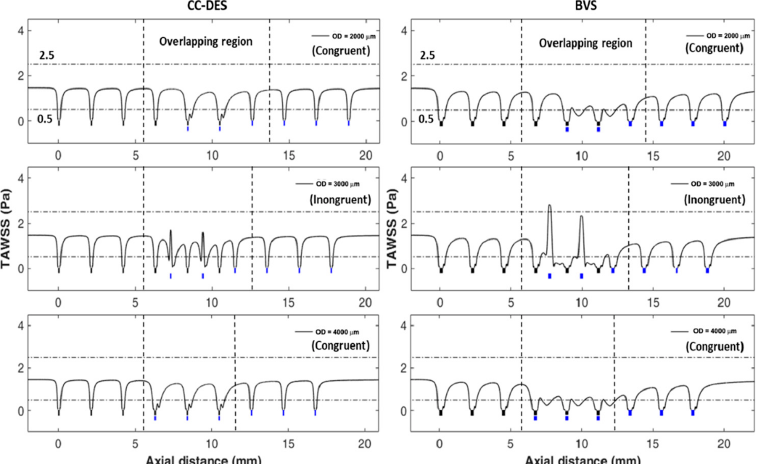
Figure 10. TAWSS distribution for overlapping configuration. For simplicity reasons, three representative configurations are displayed for each strut size. Strut locations on the X-axis are indicated with black and blue rectangles for the first and second strut respectively. Notice that axial distance = 0 mm corresponds to the location of the first stent. Three ranges can be defined: TAWSS < 0.5 Pa (Low TAWSS), 0.5 < TAWSS < 2.5 Pa (Normal TAWSS) and TAWSS > 2.5 Pa (High TAWSS).